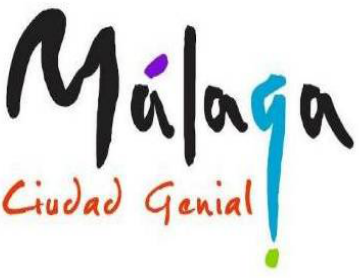
Figure 6. Promotional brand Malaga . Used with permission from Turismo Málaga [87].